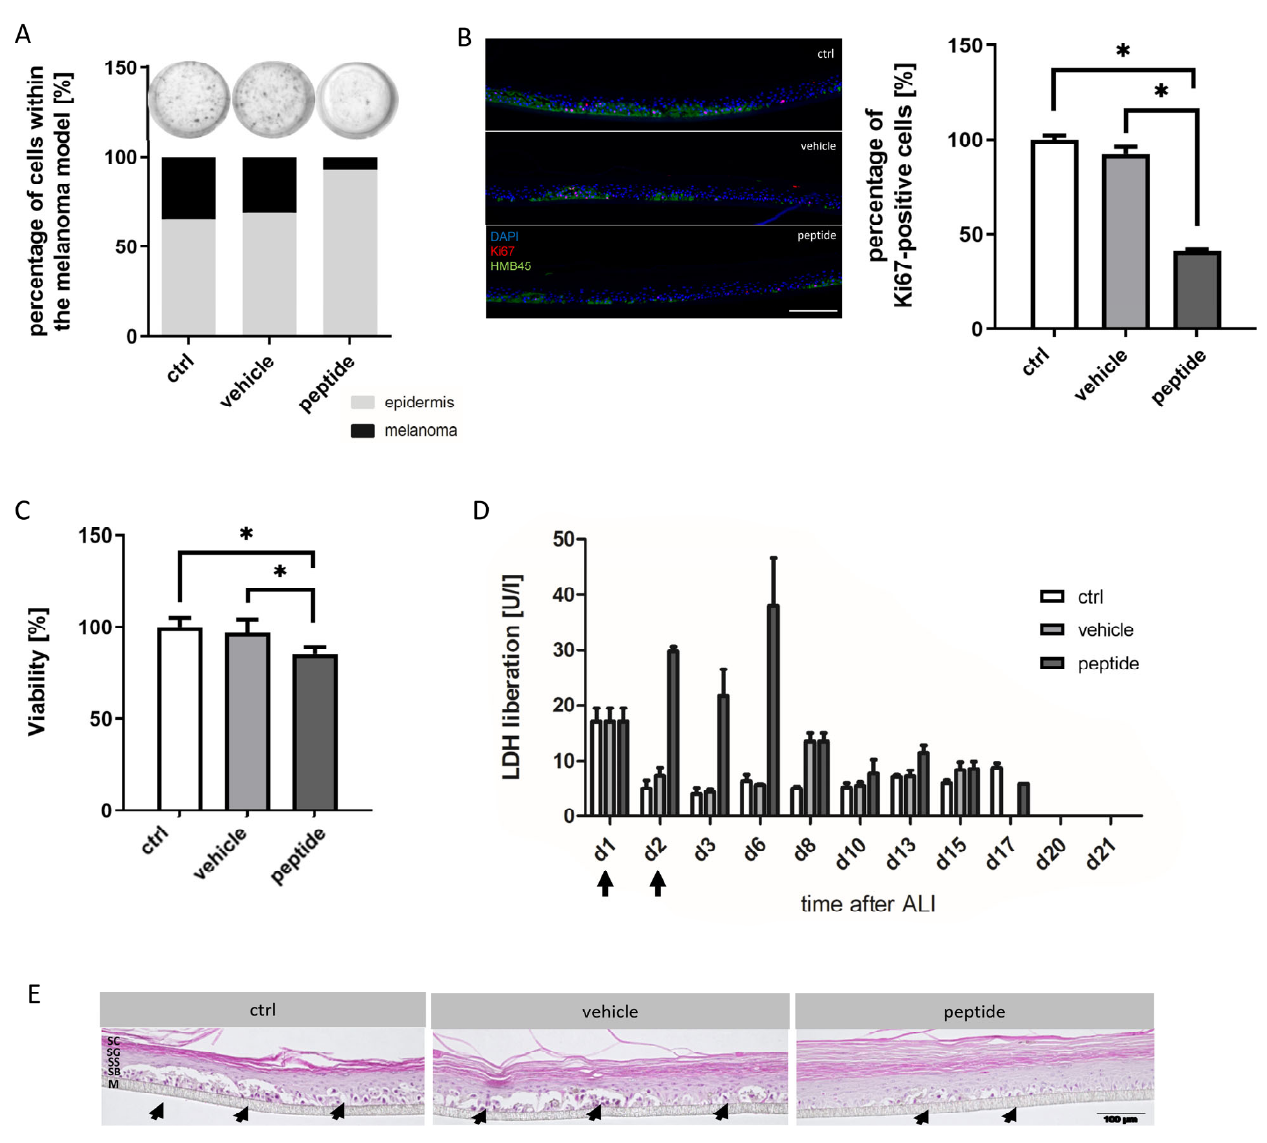
Figure 7. Quantification of the effects of RDP22 on mOSREp MUG ‐ Mel2 . ( A ): Non ‐ destructive detection of melanoma progression and regression. Images that were taken during 21 days of culture duration (Figure S3) using the MediTOM device (upper row) were analyzed with ImageJ (lower row). In the control models and models treated with the vehicle only, a comparable amount of melanoma de ‐ velopment could be detected. In models treated with RDP22, less melanoma growth and viability were detectable. ( B ): Influence on proliferation rates. Melanoma skin equivalents were stained with the melanoma marker HMB45 and the proliferation marker Ki67; subsequently, Ki67 ‐ positive cells were counted quantitatively. In models treated with the peptide, the number of positively stained cells decreased after treatment, whereas the Ki67 expression was not altered by vehicle treatment in comparison to the untreated control. ( C ): Analysis of metabolic activity. Melanoma skin models treated with the vehicle showed no significant difference in viability. In comparison in models treated with the therapeutic peptide, a weak decrease in viability was measurable after peptide treatment. ( D ): Determination of cellular integrity. LDH release was measured in the supernatant at defined time points during the whole culture duration. Arrows indicate the days where 0.1% acetic acid or RPP22 was topically applied to the melanoma models. LDH concentrations increased treat ‐ ment ‐ dependently in models treated with the peptide. ( E ): Hematoxylin and eosin staining of cross ‐ sections of melanoma skin models. While smaller and fewer melanoma nests (arrows) are detectable within a morphologically altered model upon peptide treatment, in the control and vehicle ‐ treated models a well ‐ stratified epidermis with physiologically grown tumor nests was observed. SC = stra ‐ tum corneum, SG = stratum granulosum, SS = stratum spinosum, SB = stratum basale, M = mem ‐ brane. Melanoma nests are indicated by arrowheads. Scale bar 100 μ m. Data are representative of